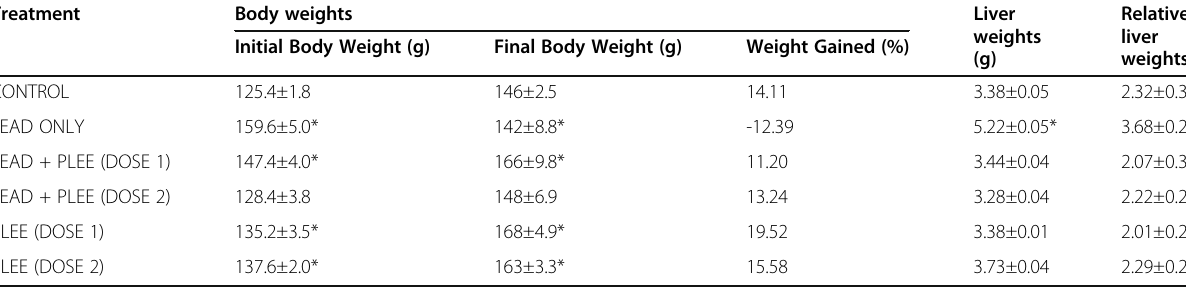
Table 1 Changes in the body weights of experimental animals exposed to Lead acetate and treated with PLEE. N = 5